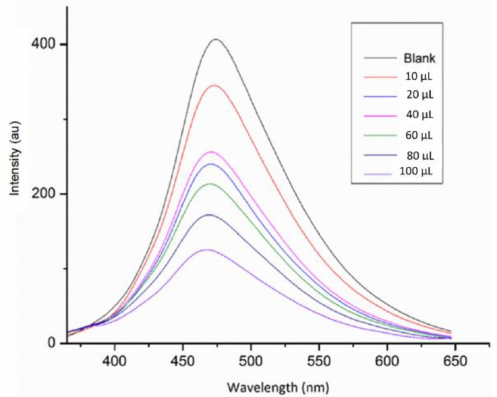
Figure 4. Fluorescence spectra from addition of various concentrations of E. coli (OD600 = 1) to mannose-coated